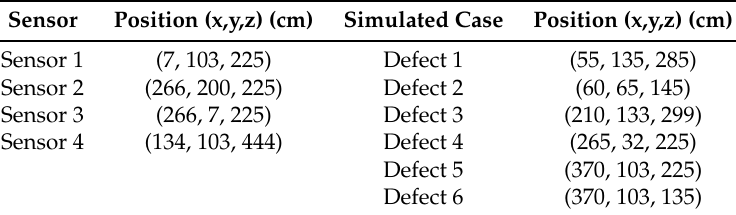
Figure 6. Model used to test the localisation algorithm. Table 2. Positions of sensors and partial discharge (PD)